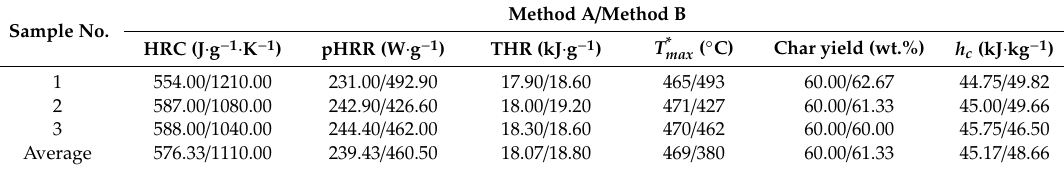
Table 3. PCFC parameters for the Façade type 2 material.